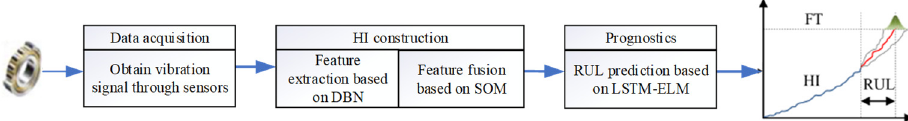
Figure 1. Flowchart of the proposed method.